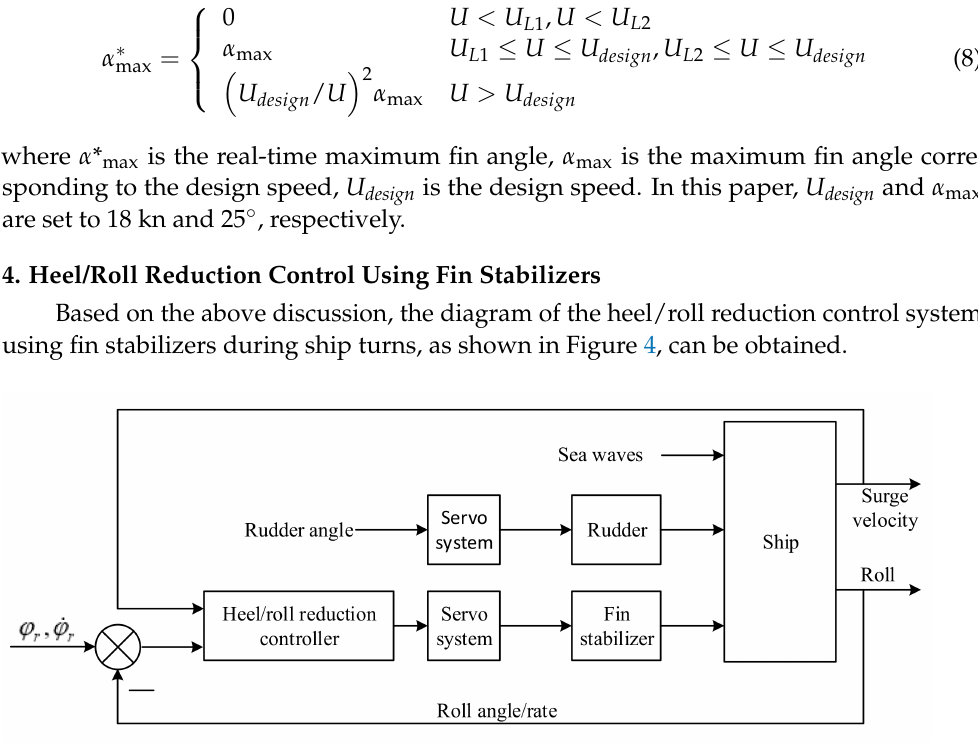
Figure 4. Diagram of heel/roll reduction control using fin stabilizers during ship